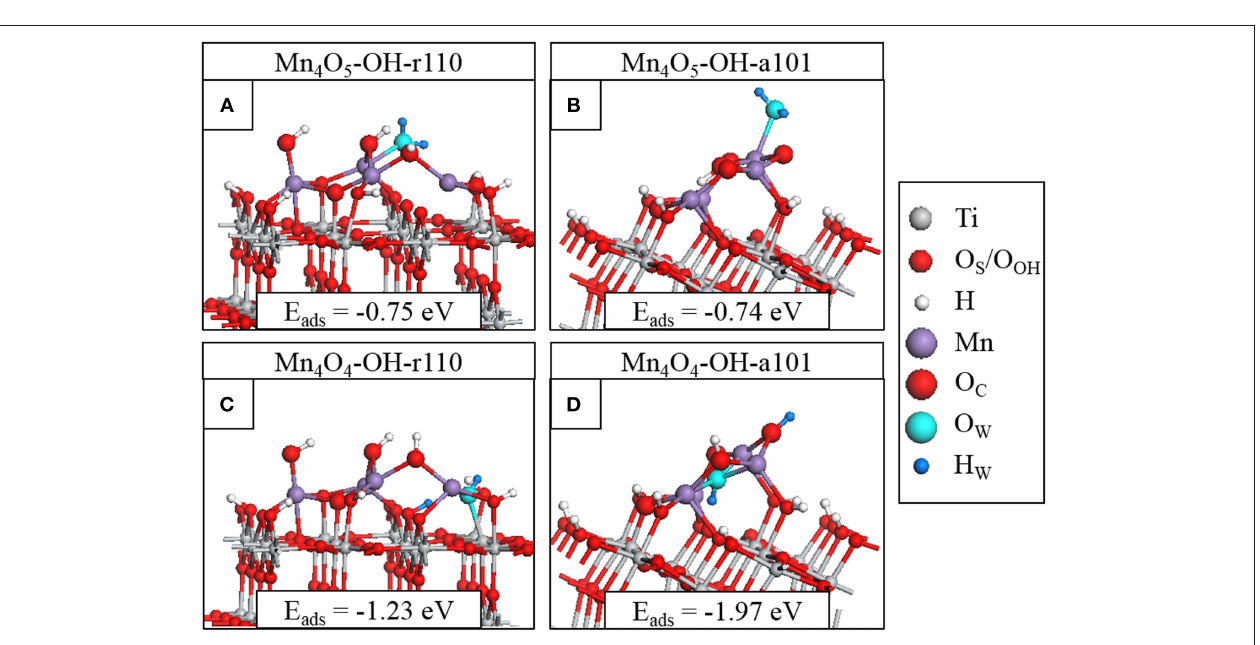
FIGURE 4 | Relaxed atomic structures of the most stable configurations of H 2 O adsorbed at (A) Mn 4 O 5 -OH-r110, (B) Mn 4 O 5 -OH-a101, (C) Mn 4 O 4 -OH-r110, and (D) Mn 4 O 4 -OH-a101. Atomic species are distinguished by color according to the legend on the right hand side. the unmodified, hydroxylated anatase (101) surface. Analysis of VBM of the composites to higher energies relative to that of the this model shows that electrons and holes localize at Mn and titania support and empty states emerge below the CBM. The neighboring O C sites, respectively, so that modification may not consequent red shift in the light absorption edge is confirmed promote separation of photoexcited charges, but the trapping by our model for the photoexcited state. In particular, the energies of the electron and hole are quite high, suggesting vertical energy, analogous to the optical energy gap, decreases high significantly for Mn 4 O 5 -OH-a101 relative to that computed for